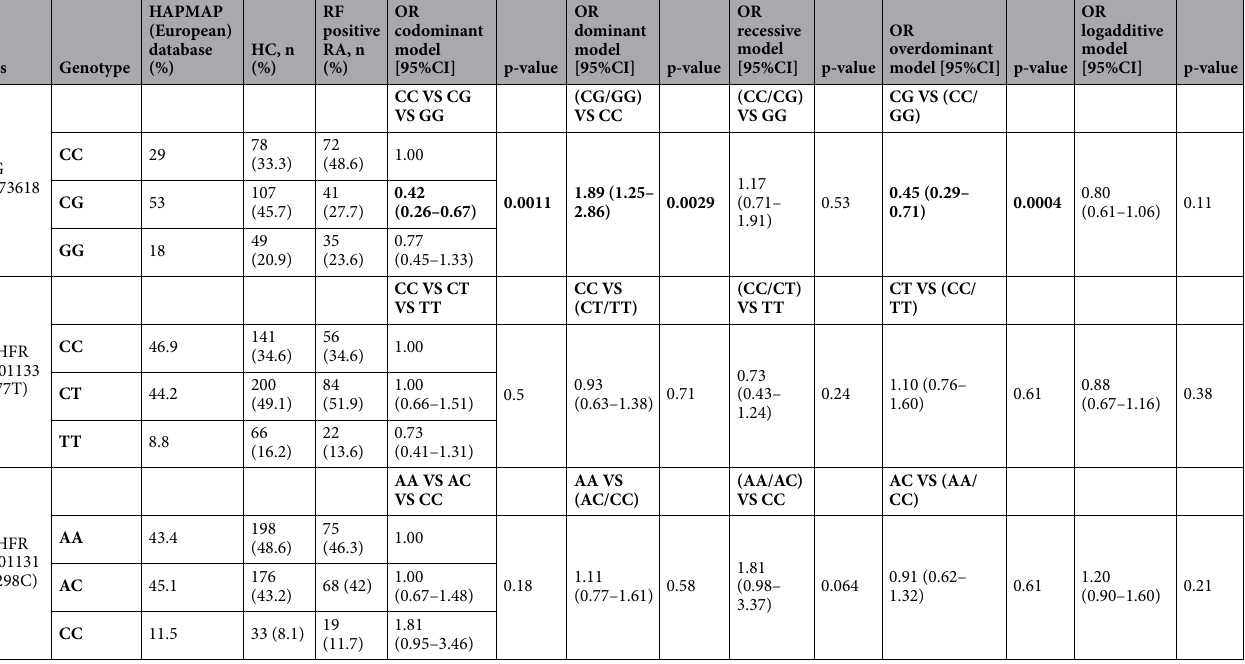
Table 3. Prevalence of the OPG rs2073618 and the MTHFR rs1801133 and rs1801131 SNP genotypes in RA RF positive patients and HC, adjusted by gender and age. Genotypes, OR and p-value for the five genetic models (codominant, dominant, recessive, overdominant and additive) were estimated with SNPstats software (statistically significant if p < 0.05). OPG osteoprotegerin, MTHFR methylene tetrahydrofolate reductase, OR odds ratio, SNP single nucleotide polymorphism, VS versus, RA rheumatoid arthritis, HC healthy controls, RF rheumatoid factor, HAPMAP haplotype map. Significant values are in bold.